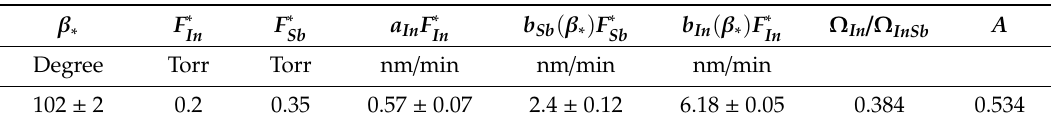
Table 1. Parameters describing the morphological evolution of InAs / InSb NWs and In droplets under F In = 0.2 Torr and F Sb = 0.35